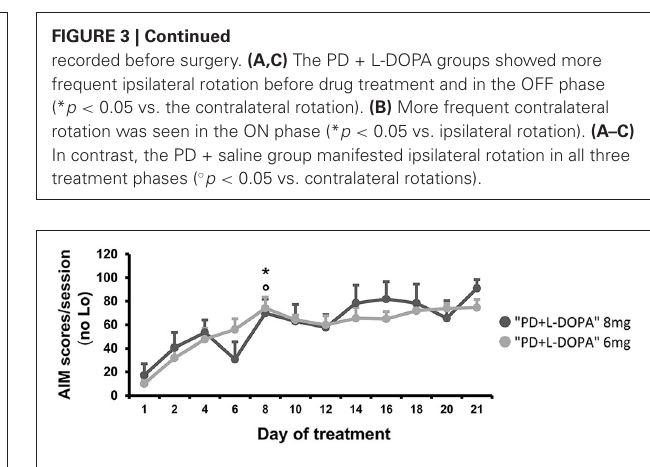
FIGURE 4 | AIM scores . Comparison of the bodily (axial, limbic and orolingual) AIM scores developing during chronic treatment at two different L-DOPA dosages. For each day, a total AIM score was calculated as the sum of the basic score multiplied by the amplitude score for each AIM subtype, excluding the locomotive subtype (Lo). The graph expresses the mean of the total AIM scores ( ± S.E.M.) for all animals during each day of treatment. The severity of the bodily AIMs increased after 1 week (from the eighth day) of daily L-DOPA injections in both treated groups (PD + L-DOPA 8 mg: